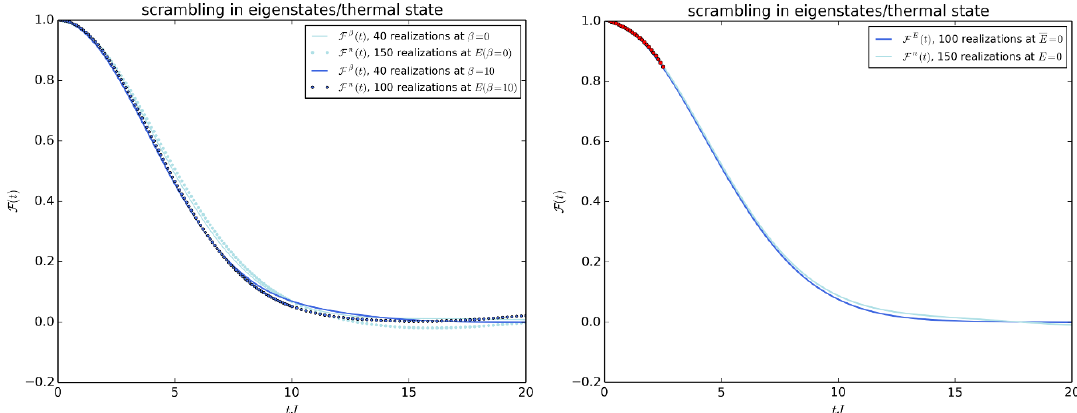
Figure 6 . Four-point out-of-time order (OTO) correlation function of the hopping operator. Left panel: four-point OTO correlation function in individual eigenstates vs. thermal OTO correlation function at temperature (cid:12) ( E ) = 0 ; 10 (for N = 7). Right panel: four-point OTO correlation function in individual eigenstate j n i vs. thermal OTO correlation function in the microcanonical ensemble at energy (cid:22) E = E n (for N = 7) with a (cid:12)t to the functional form (2.11), (4.18) for (cid:11) = 0 : 033 : : : and (cid:21) = 0 : 69 : : :